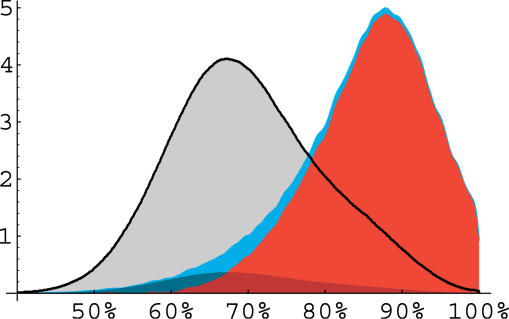
Empirical Distribution of Sequence PID to MouseShown is the PID distribution for human segments under indel-purifying selection (at a 1% FDR; blue), and a background distribution obtained on putatively neutrally evolving segments (non-exonic, and not in identified set of segments at 10% FDR; grey). The blue distribution can be decomposed as a mixture of 6% background (shaded) and a remainder (red), suggesting that a proportion of ungapped elements (≈ 5%, mixture coefficient minus FDR of 1%) are under purifying selection with respect to indels, while evolving under relaxed constraints or positive selection with respect to substitutions (see Materials and Methods).